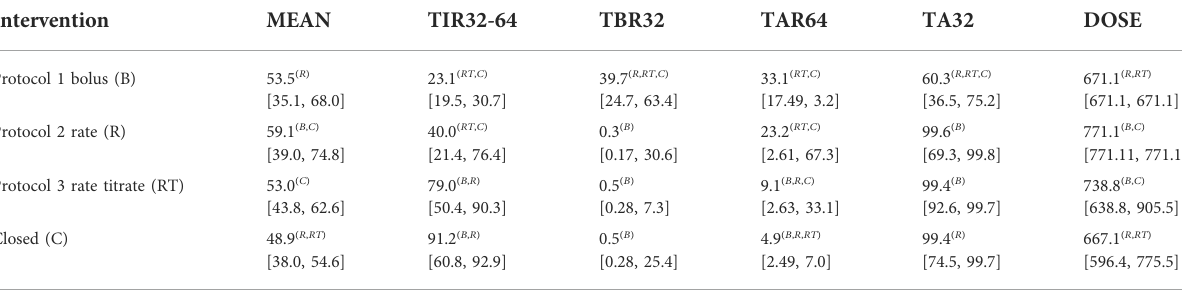
TABLE 1 Comparison of protocols 1, 2, and 3 with closed-loop control for piperacillin-tazobactam delivery. Intervention MEAN TIR32-64 TBR32 TAR64 TA32 DOSE